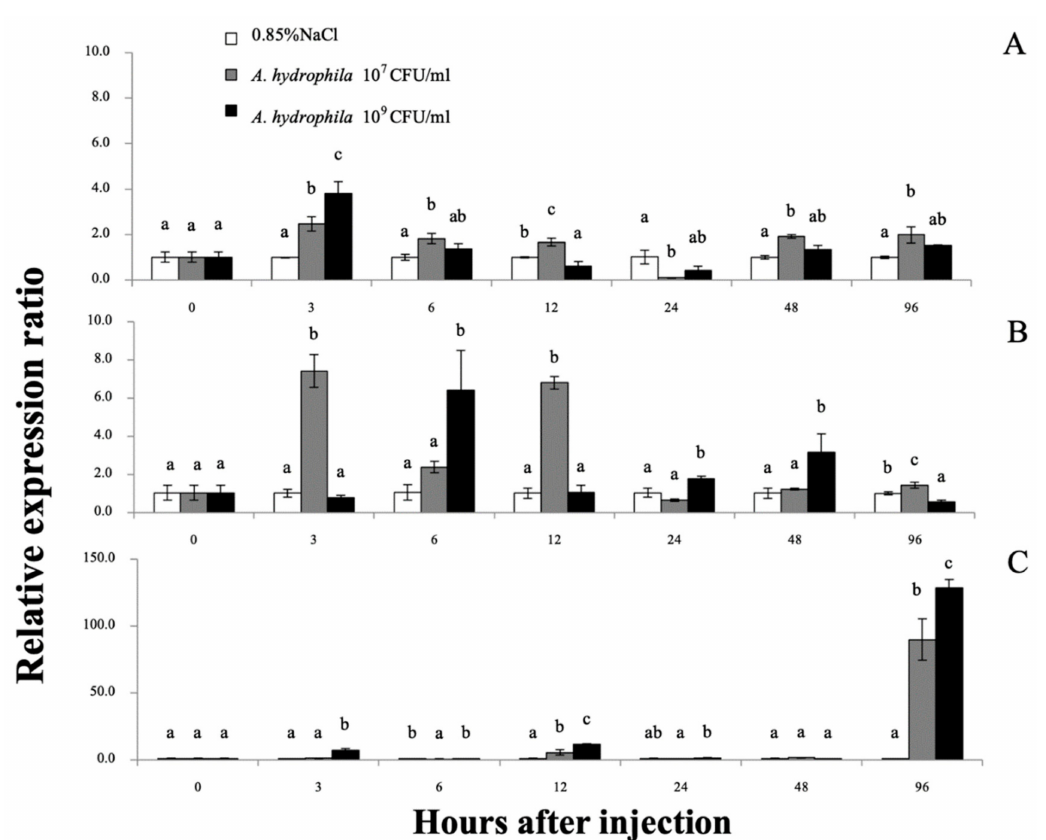
Figure 9. The Mr-hsp90 mRNA expression levels relative to β -actin levels analyzed by qRT-PCR. in the gills ( A ), hepatopan- creas ( B ), and hemocytes ( C ) of giant river prawns after challenge with Aeromonas hydrophila . Data with different letters (a, b and c) were significantly different ( p < 0.05) at the same exposure